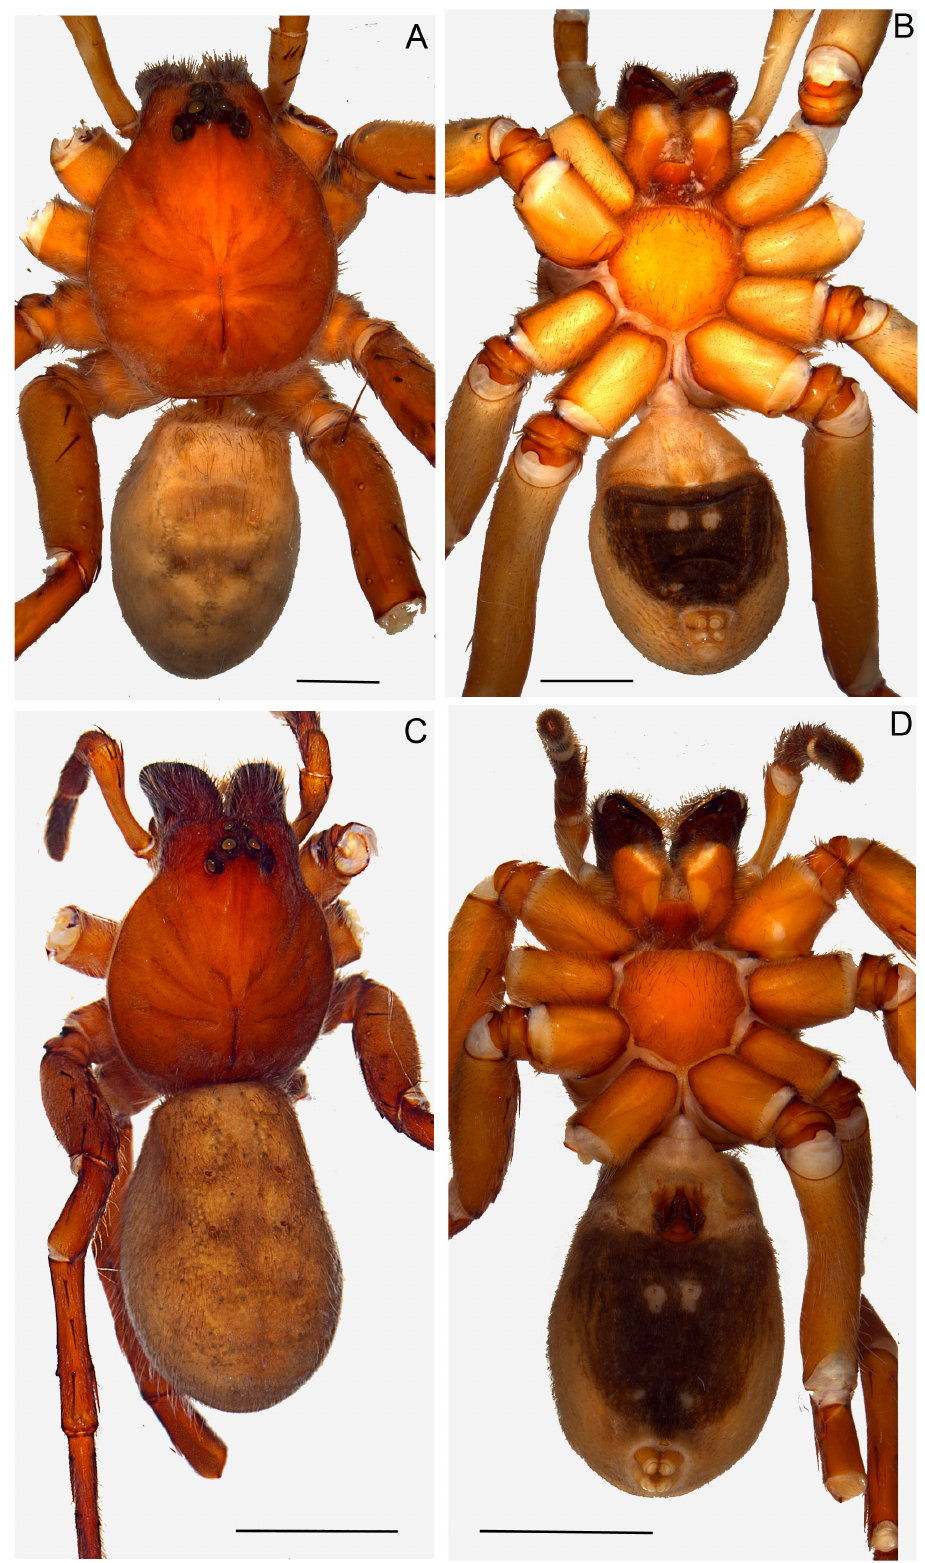
Fig. 8. Afroneutria quadrimaculata sp. nov. Habitus. A . ♂ , dorsal view. B . ♂ , ventral view. C . ♀ , dorsal view. D . ♀ , ventral view. Scale bars = 2